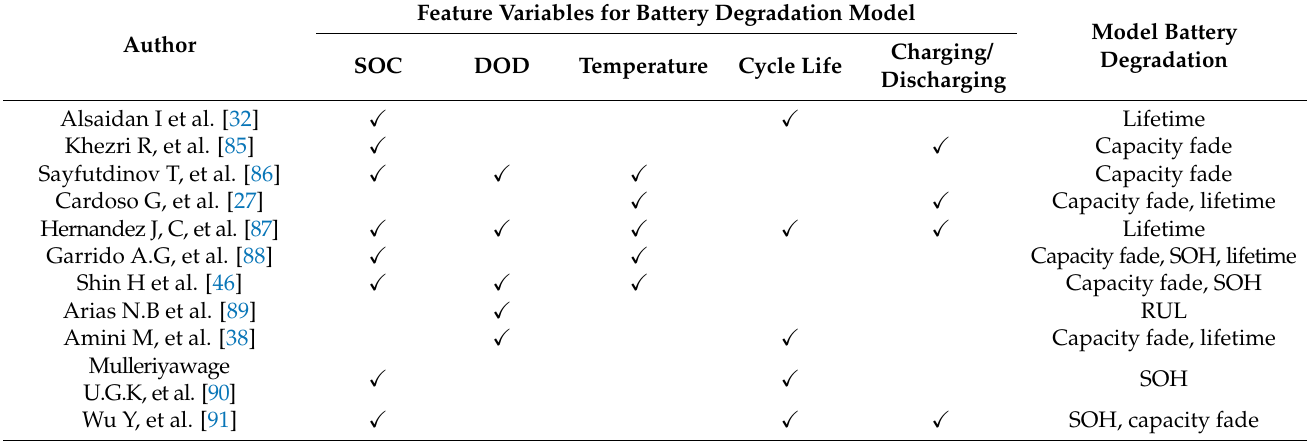
Table 9. Review of variable features used in battery degradation models for optimization of BESS sizing and siting.